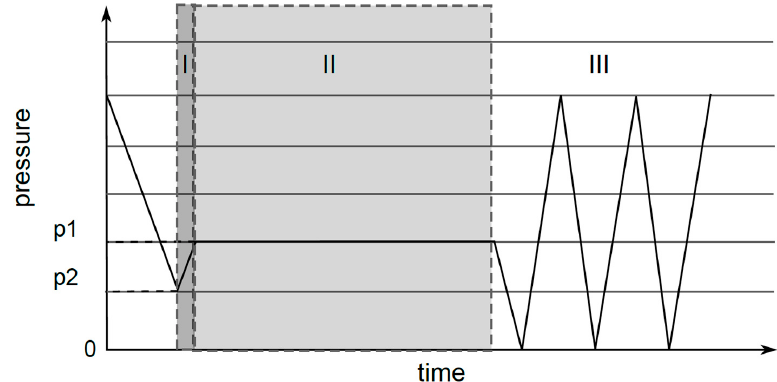
Figure 1. Oxy-fluorination process with evacuation of batch reactor until pressure p2, purging with F 2 /N 2 mixture (10:90 vol%) until p1 (I), processing (II), and multiple evacuations and purging with air until all remaining fluorine is removed (III).